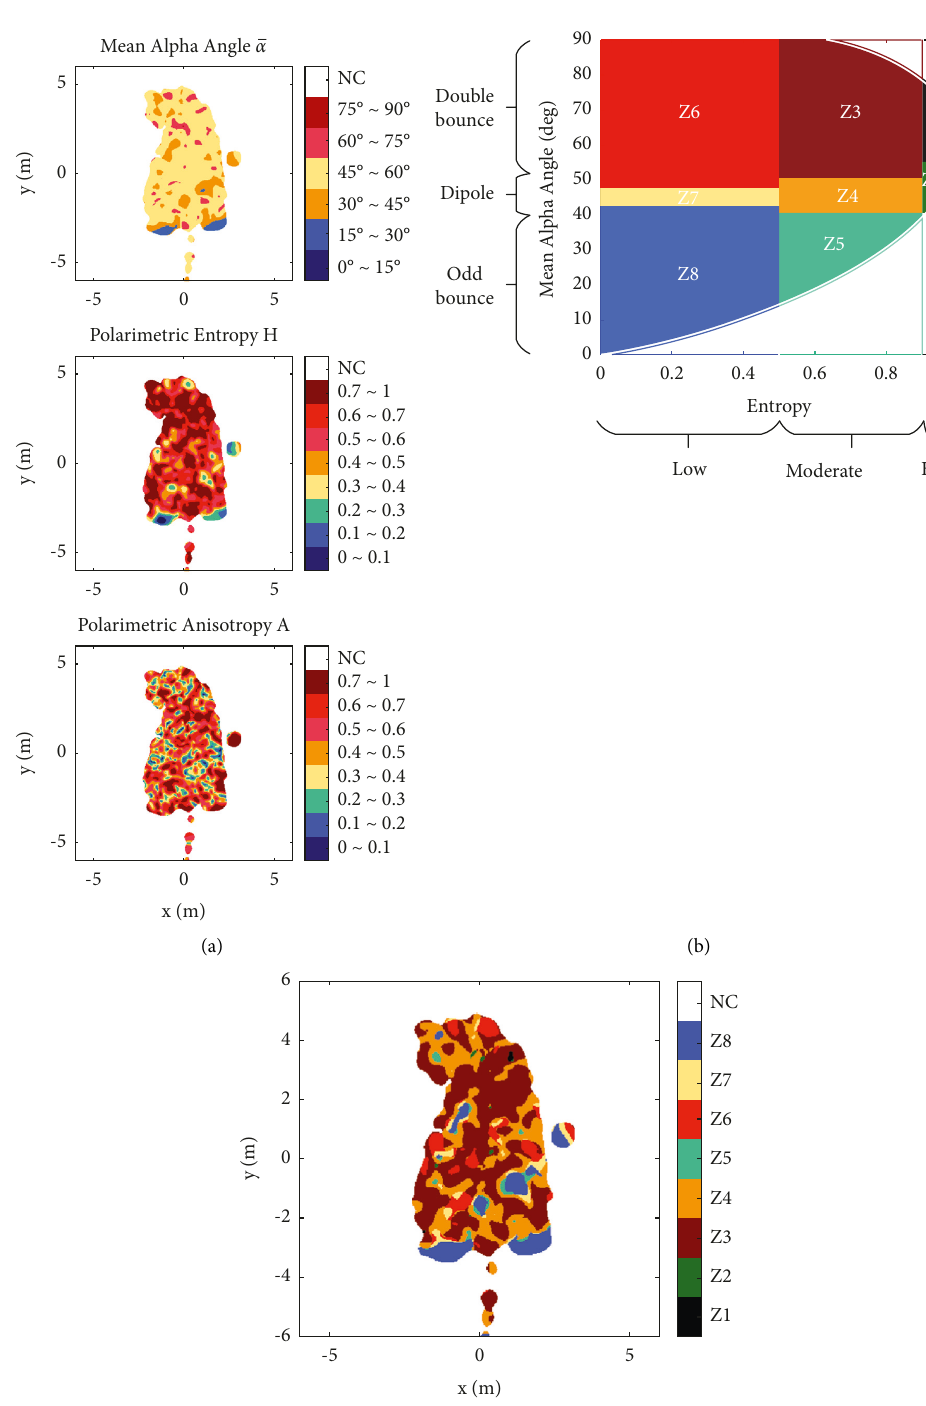
Figure 10: Eigenvector/eigenvalue decomposition results. (a) Distributions of the three extracted parameters. (b) H / α classification plane with its division into eight classes and their color coding. (c) H / α classification result (NC: not